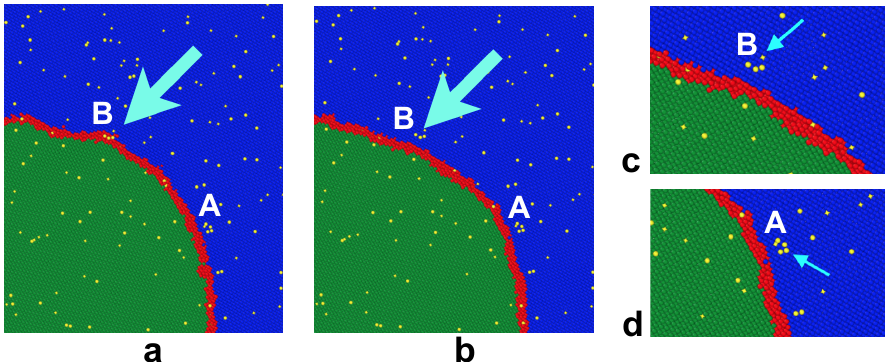
Figure 6. Interaction of the moving GB with solute clusters. Cu atoms of the outer and inner grains are shown in blue and green, respectively, with GB atoms shown in red and Ag atoms in yellow. The GB is moving towards the lower left corner of the images. In ( a ), the GB has just separated from the group of atoms (cluster) A but is still pinned by the cluster B. In ( b ), the GB broke away from the cluster B. Panels ( c , d ) are zoomed in views of the two clusters. The cyan arrows point to the